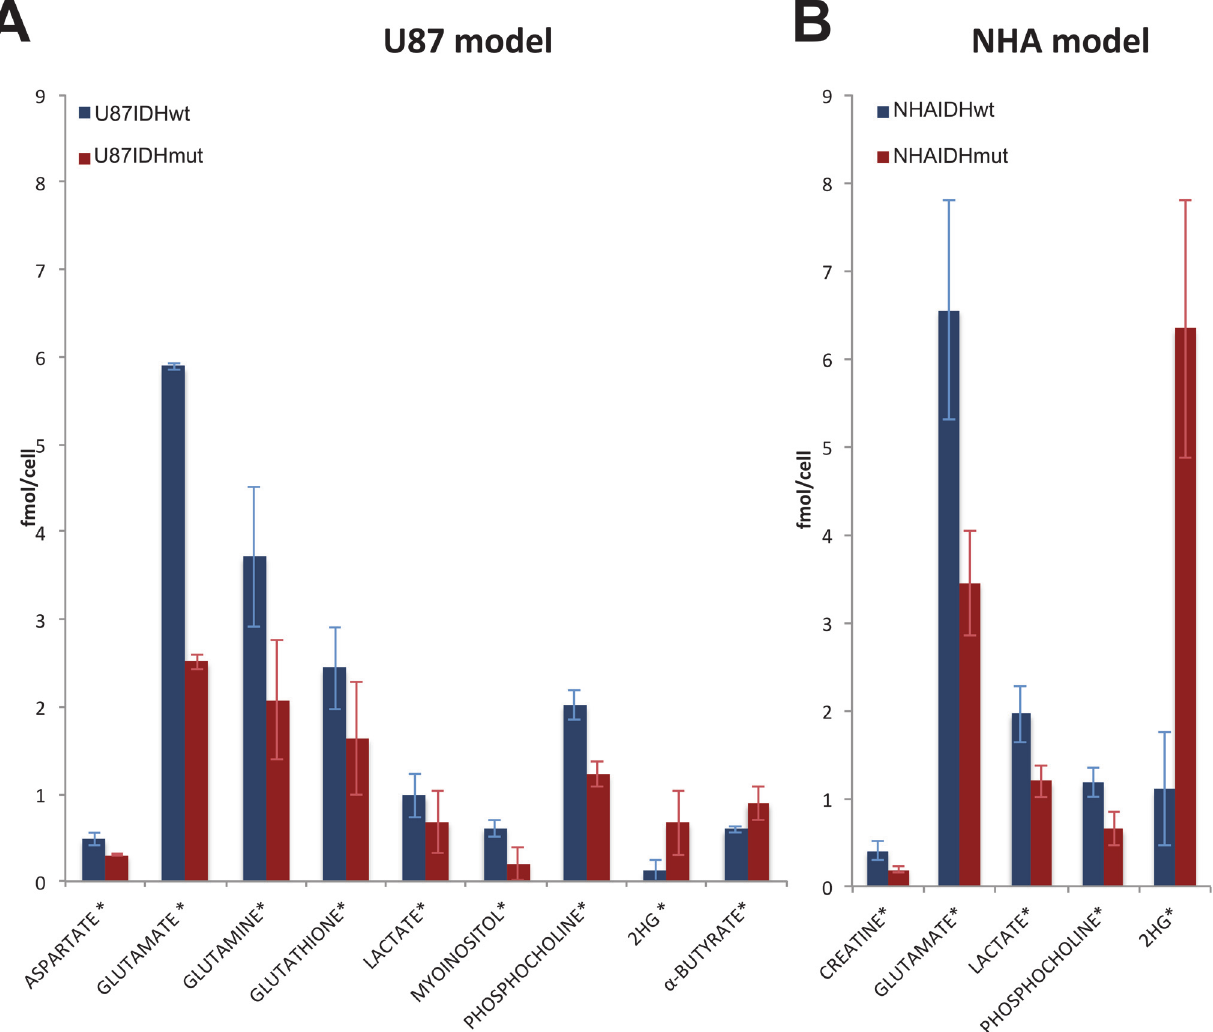
Fig 6. 1 H-MRS reveals the metabolic reprogramming associated with the IDH1 mutation. The intracellular concentration of the metabolites that differ significantly between IDHwt and IDHmut cells were quantified for U87 (A) and NHA (B) cell